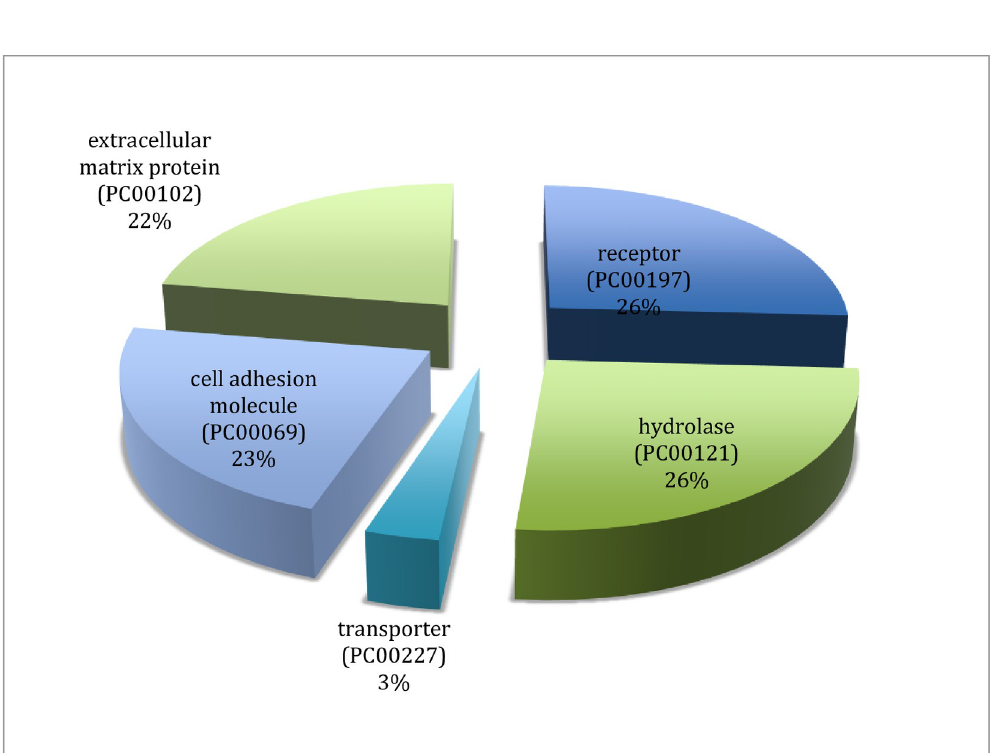
Fig 9. Gene ontology of down regulated genes in pansteatitis showing their protein classification.